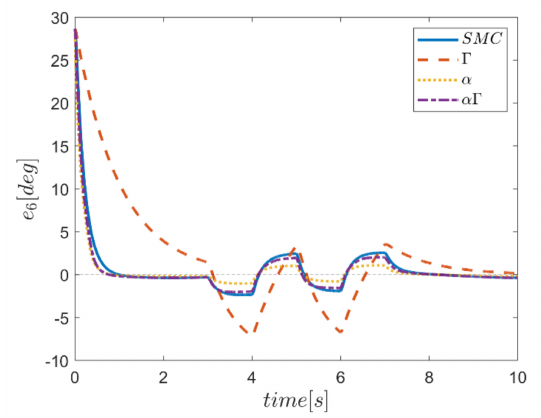
Figure 23. Tracking error in the ψ